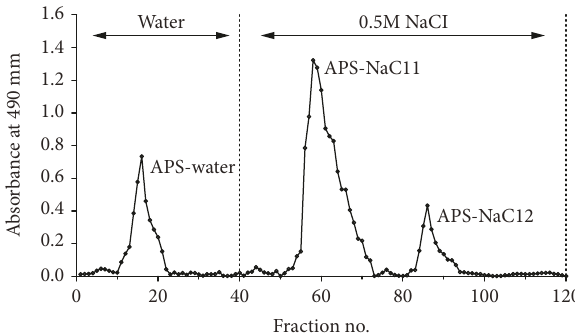
Figure 1: Elution curve of polysaccharide fractions from crude APS by DEAE-52 cellulose column